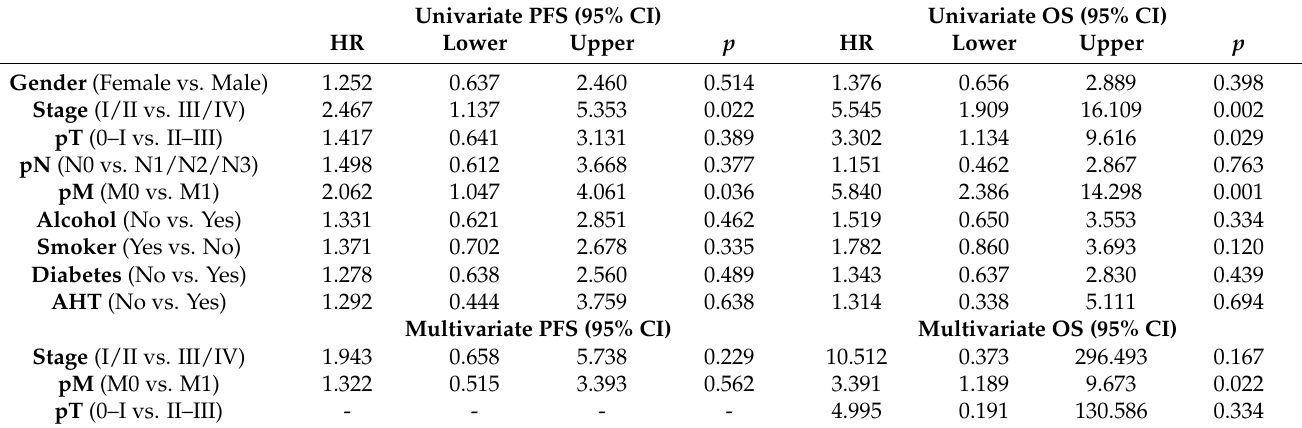
Table 1. COX proportional hazard model for clinico-pathological characteristics of